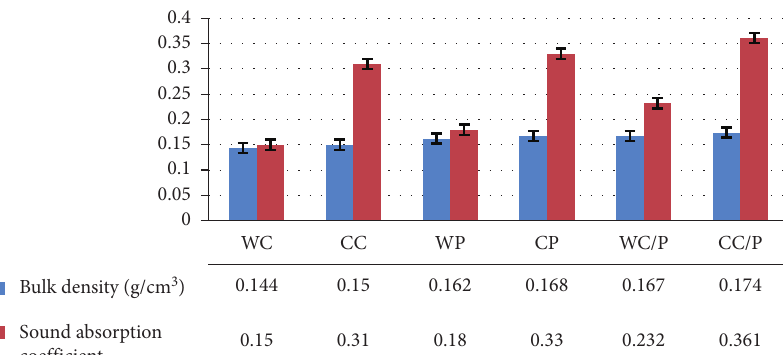
Figure 7: Influence of density on sound absorption coefficient.